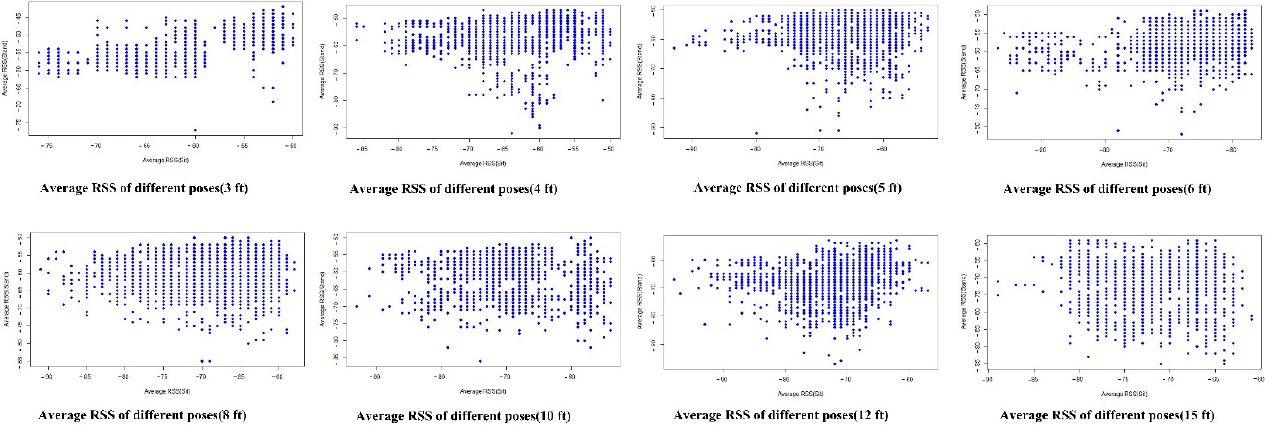
Figure 8. RSSI of different poses and distances.